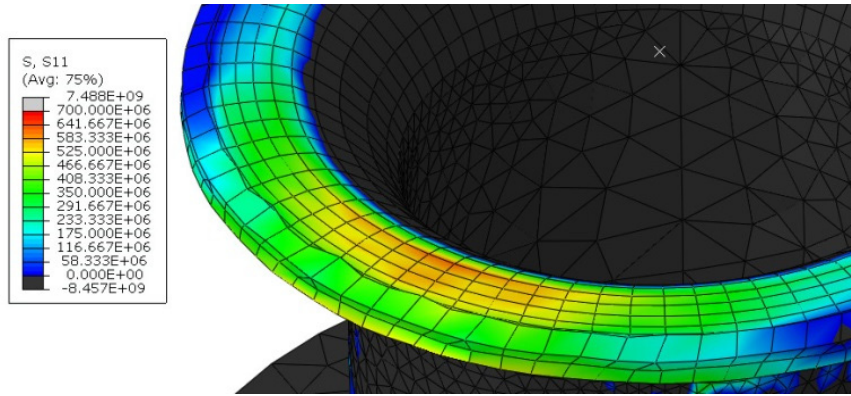
Figure 4. FEM ‐ EA simulation of the initial phase of the riveting process.